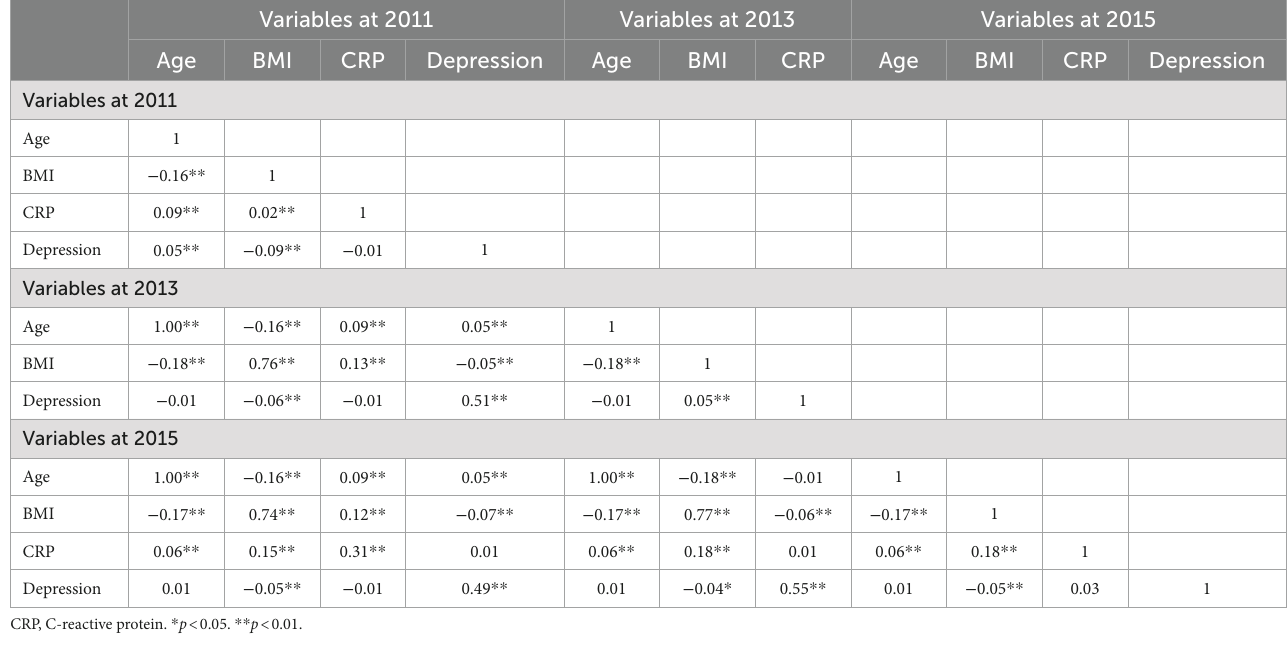
TABLE 3 Correlation analyses between continuous control variables, depression and CRP.